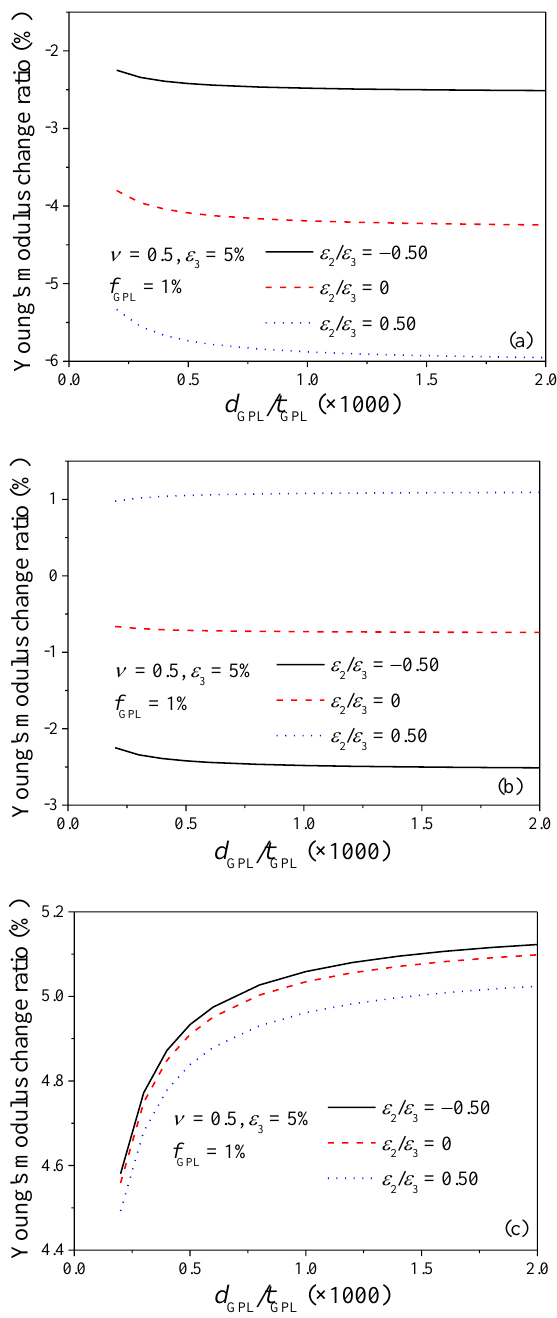
Figure 11. Effect of GPL dimension on Young’s modulus change ratio of GPL/epoxy nanocomposites ( a ) X 1 -direction; ( b ) X 2 -direction; ( c ) X 3 -direction. ( a ) X 1 -direction; ( b ) X 2 -direction; ( c ) X 3